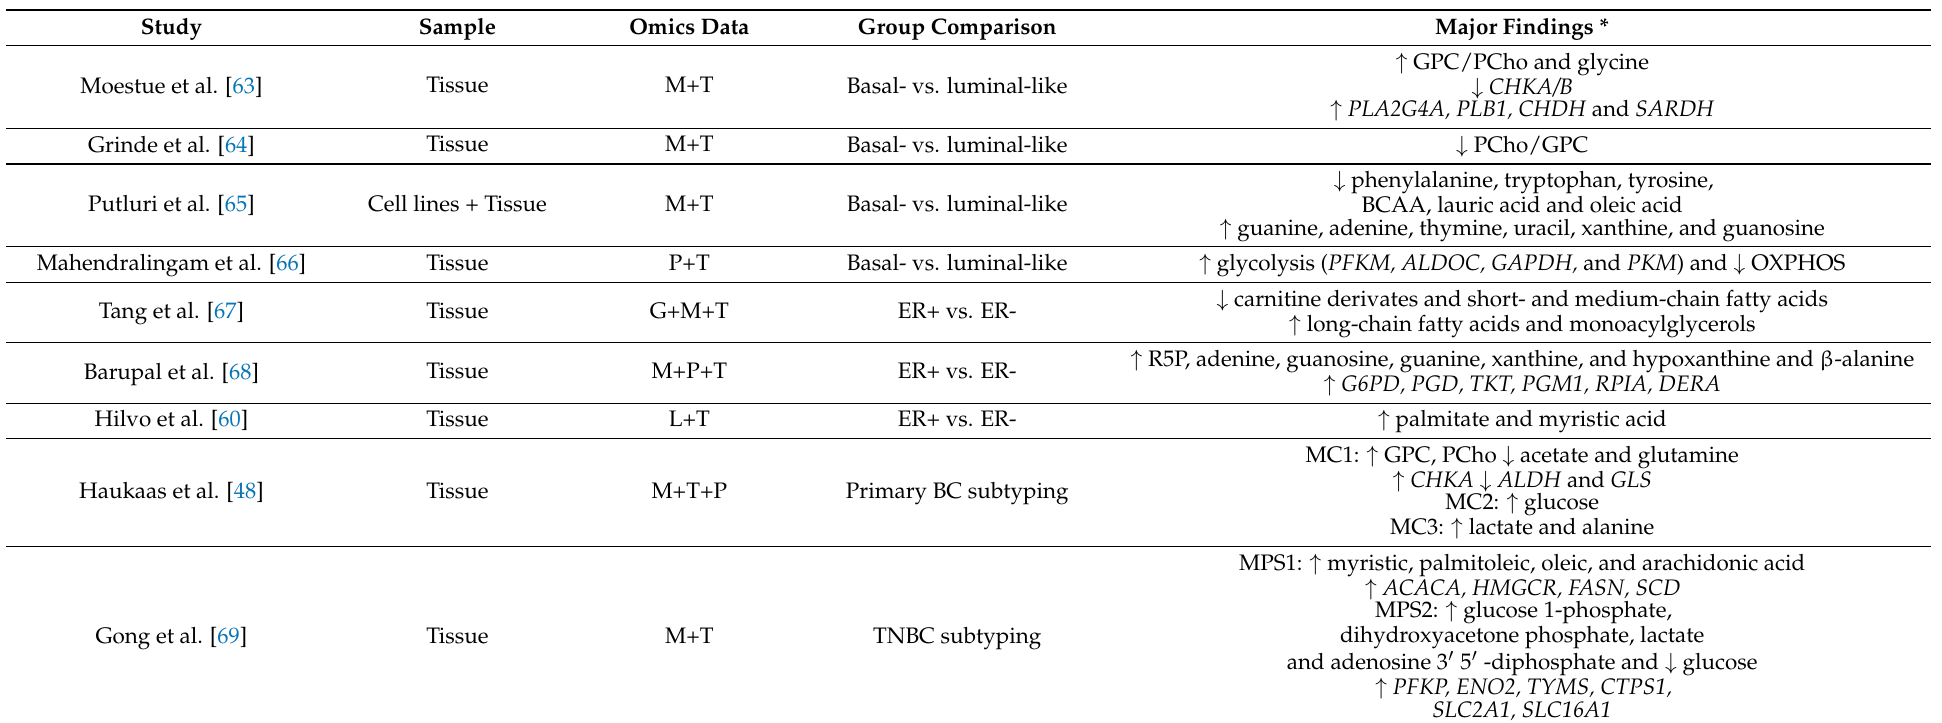
Table 2. Multi-omics studies focused on BC tumor metabolic